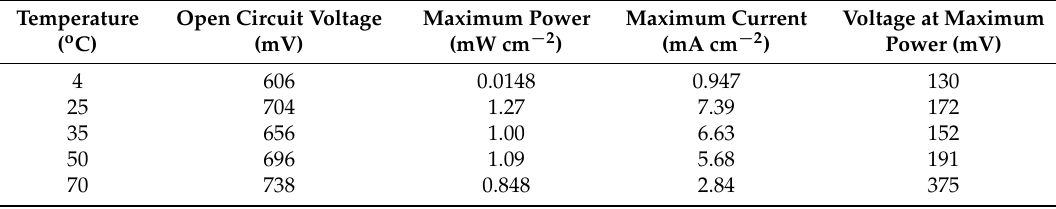
Table 2. The resulting open circuit voltage (mV), Maximum power (mW cm − 2 ), maximum current (mW cm − 2 ), of glycerol fuel cells in 8 M KOH and 1.4 M glycerol solutions at different